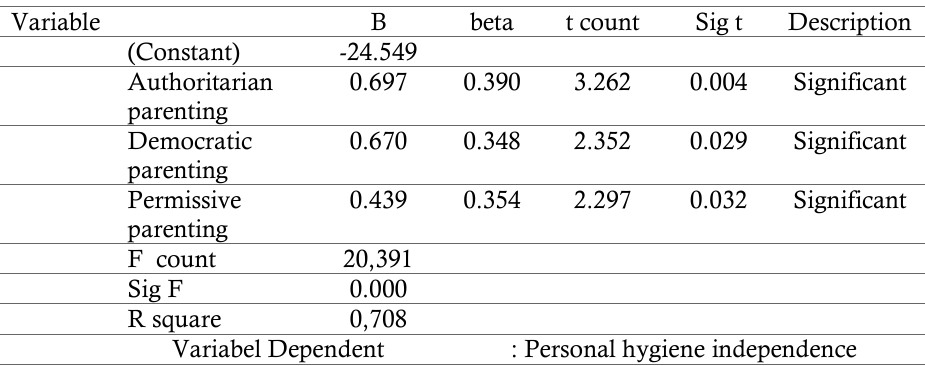
Table 1. Multiple Linier Regression Test